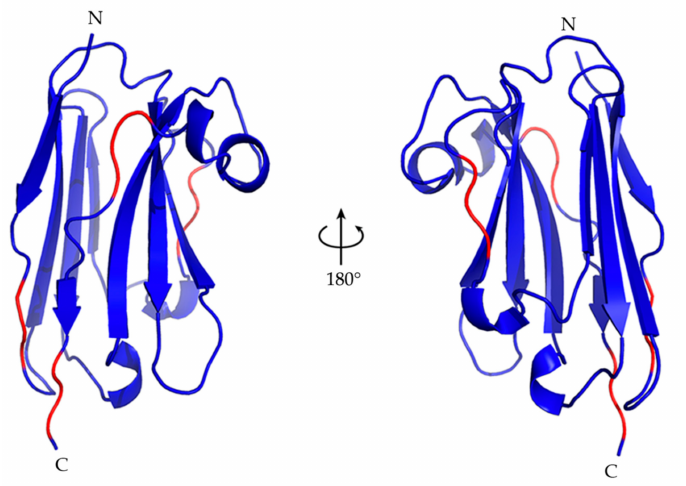
Figure 4. The best Nb23 structure from energy minimization of the NOE-restrained PONDEROSA C/S models. The structure is the lowest energy conformer of the NOE-restrained best cluster deposited in PDB (7EH3). It has the general features of a variable immunoglobulin domain, with the characteristic extended CDR3 of nanobodies which for Nb23 shields the solvent-exposed hydrophobic sidechains of Phe37, Phe47, Ile51, and Trp119. The β -strand content in the NOE-restrained best cluster is under-represented with respect to the analogous content of the CS-Rosetta structure ensemble. The red color highlights the location of the fragments extended but devoid of regular β -structure. Table 3 shows the positions of the β -strands for each structure of the NOE-restrained best